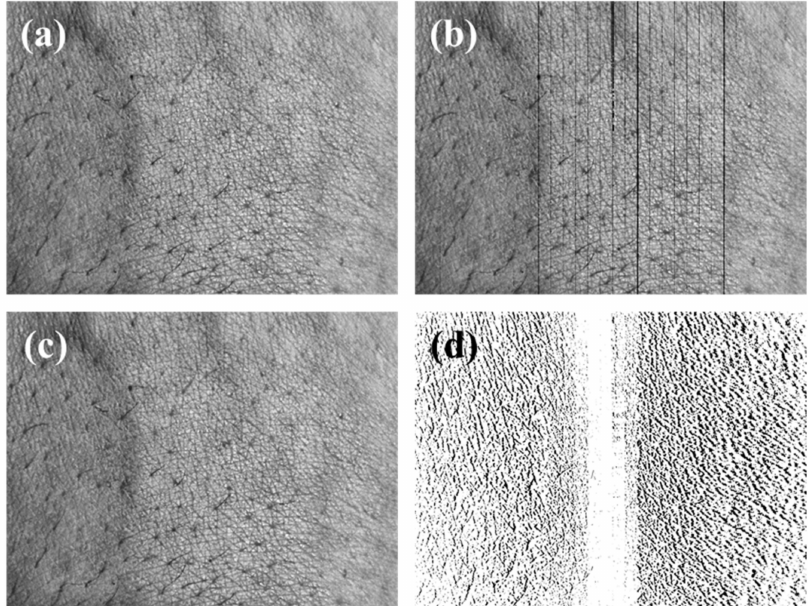
Figure 11. The distortion correction results of the mobile skin image acquiring the working distance of 80 mm. ( a ) The distorted original skin image, ( b ) the corrected skin image, ( c ) the interpolation skin image, ( d ) the subtraction image from the distorted image and the interpolation